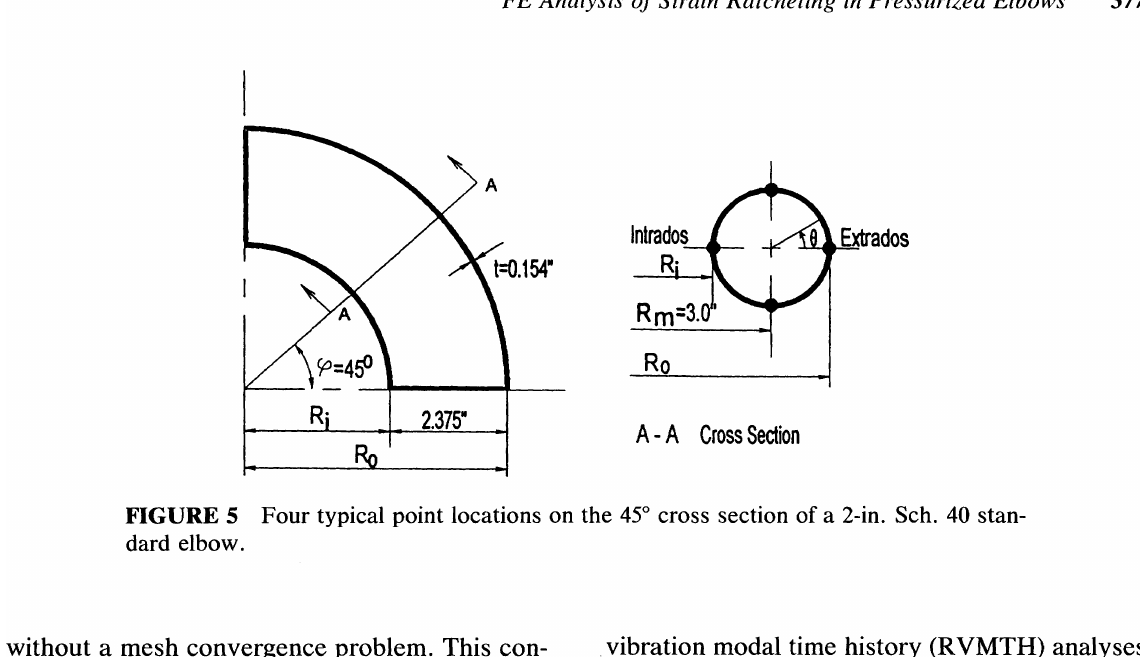
FIGURE 5 Four typical point locations on the 45° cross section of a 2-in. Sch. 40 stan dard elbow.